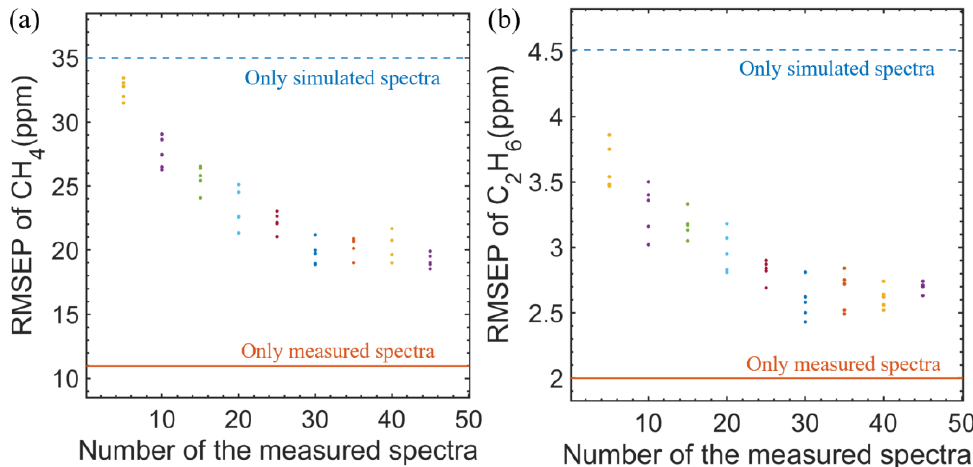
Figure 14. The RMSEP of ( a ) CH 4 and ( b ) C 2 H 6 obtained by training with 49 simulated spectra data and different numbers of measured spectra data.